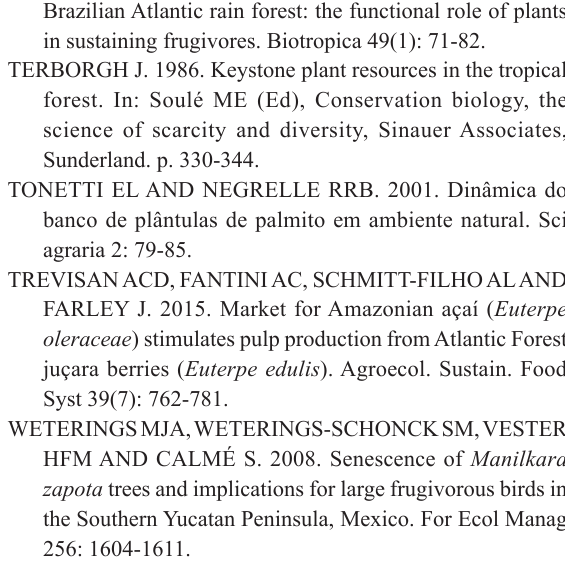
Table SI - Wildlife recorded in Ibirama National Forest (Management Plan A and this study) associated with the consumption of Euterpe edulis fruit and pulp of by Galetti et al. (2013), Campos et al. (2012), and this study. Figure S1 – a) Model of fruit collectors installed in the study area. b) and c) Using camera traps to monitor infructescences.